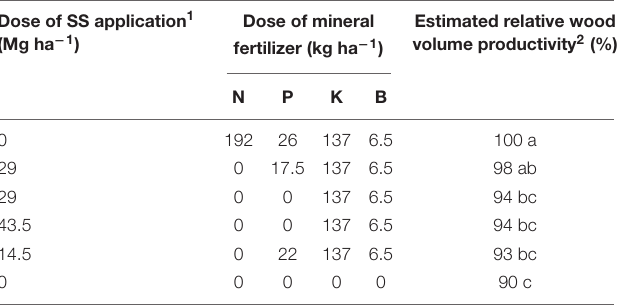
TABLE 6 | Doses of nitrogen, phosphate, potassium, and boron mineral fertilizer applications for E. urograndis planting, as a function of the sewage sludge doses, based on the N